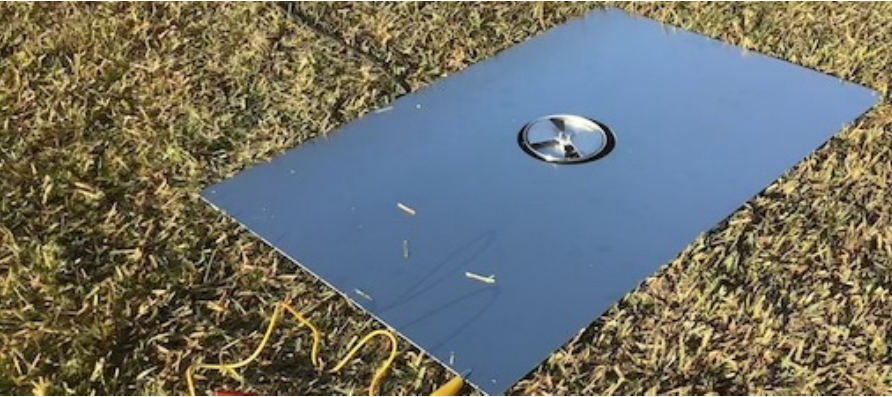
Figure 4. Picture of EFM system temporally installed to measure the fair-weather electric field at ground level.